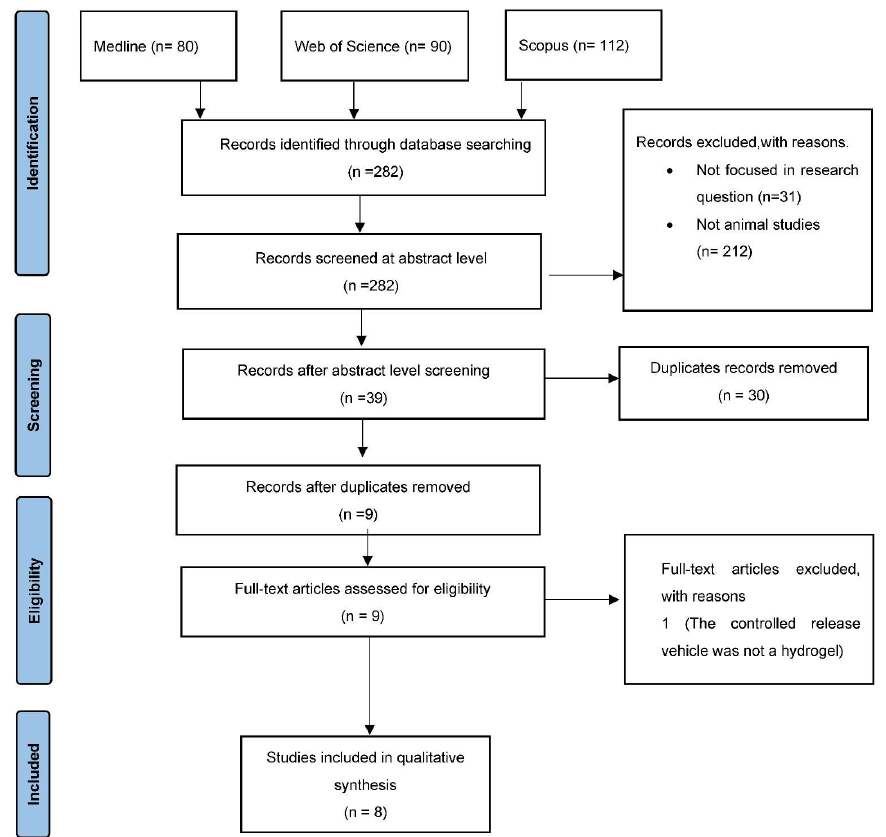
Figure 1. PRISMA flow diagram of record processing and elimination.